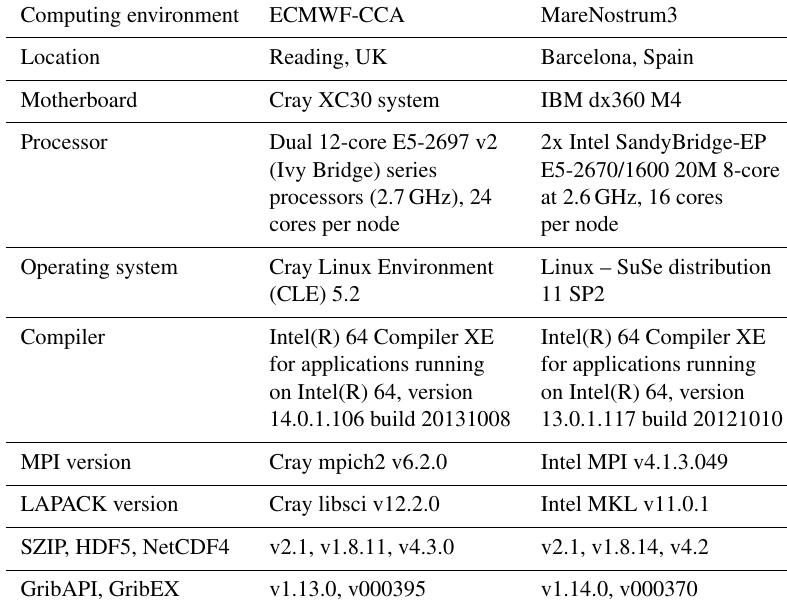
Table 1. The two computing environments considered in this study.